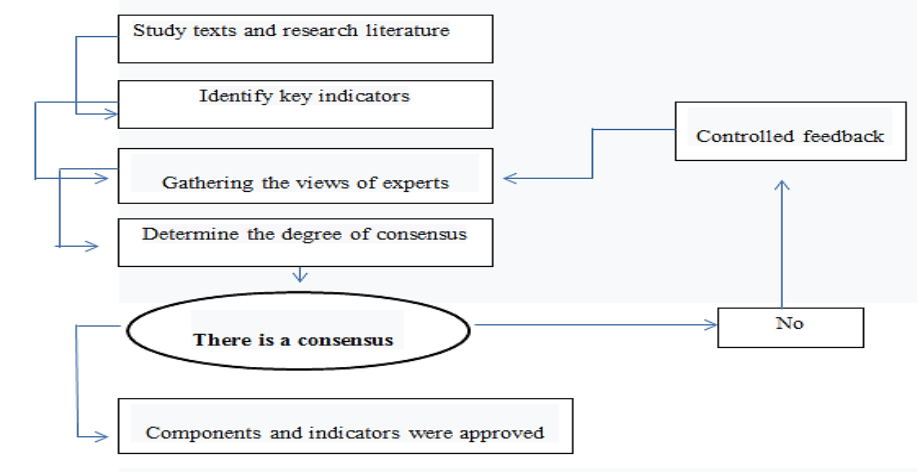
Fig. 4. Confirmation steps for identified